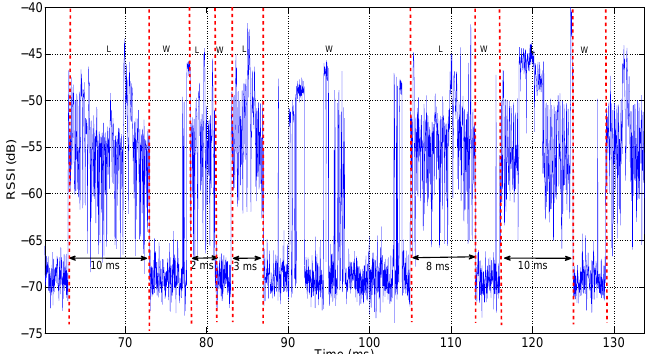
Figure 13. An illustration of the fabricated RSSI trace, consisting of arbitrarily interleaved RSSI from Wi-Fi (indicated by ‘W’) and LTE (indicated by ‘L’). Note that the duration of continuous LTE RSSI is chosen within (2,3,8,10) ms to be compliant with the recent LTE License Assisted Access (LAA)